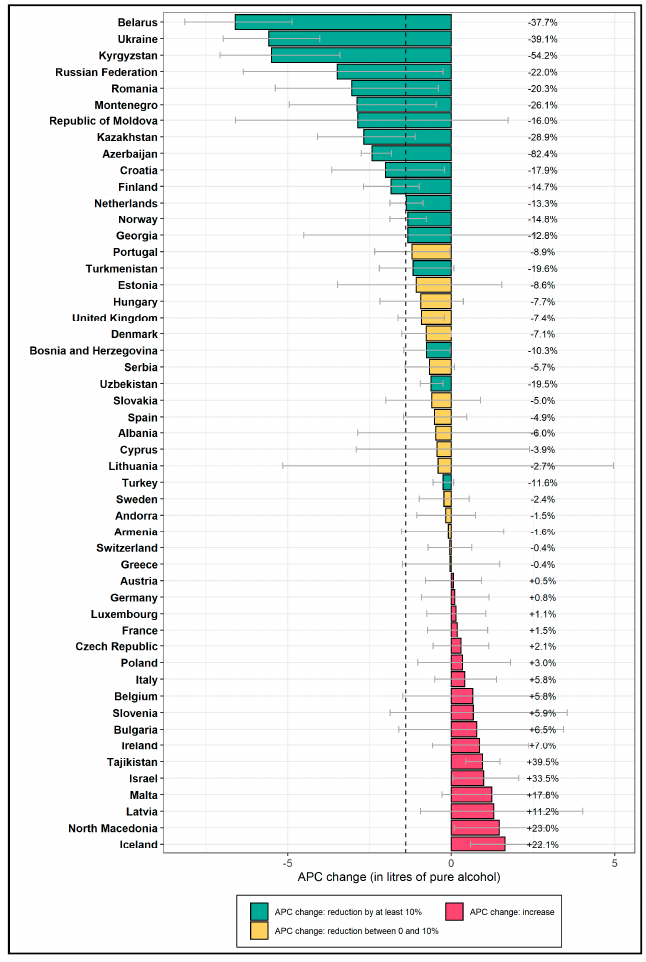
Figure 1. Changes in alcohol per capita consumption (APC) in the total adult population between 2010 and 2017, by country. Absolute changes are shown on the x-axis in liters of pure alcohol; relative changes are indicated as percentages on the right of the graph and in the color-coding. Countries that are shown in green already achieved the target of an at least − 10% reduction in APC. The dashed vertical line indicates the mean absolute change in the WHO European Region.